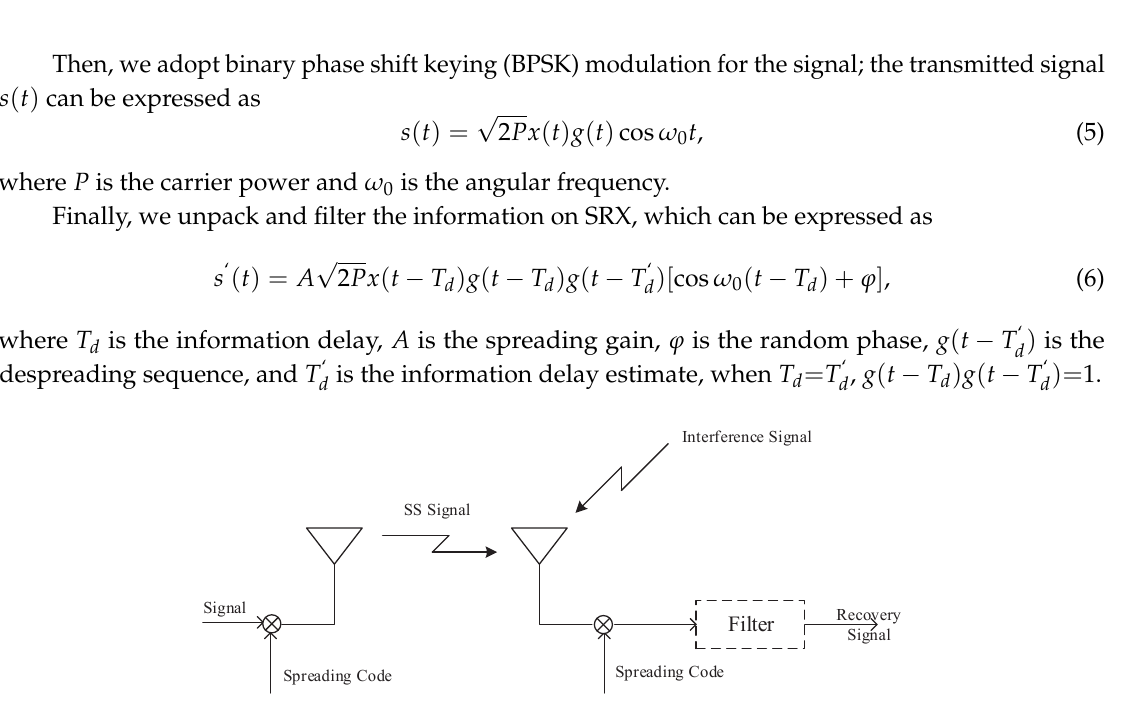
Figure 1. DSSS technology schematic.